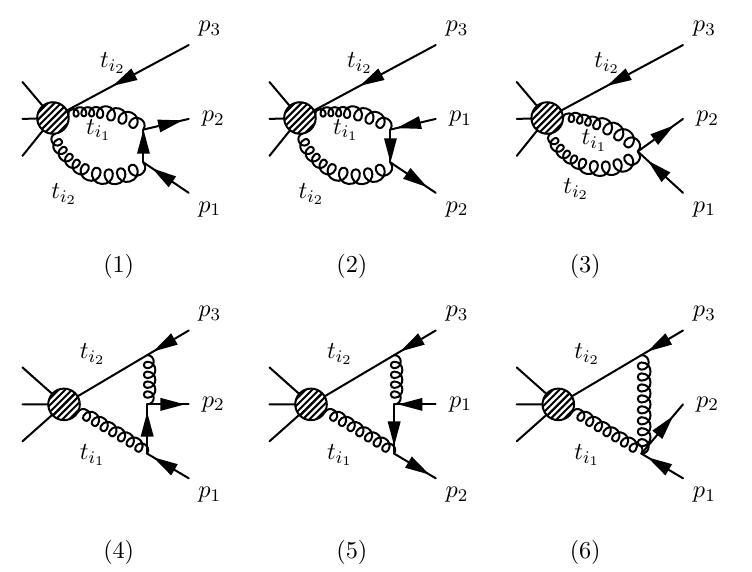
J C 2 of a B - into a C -type current (cid:31) (cid:22) (cid:31)(cid:31) A @(cid:31) !